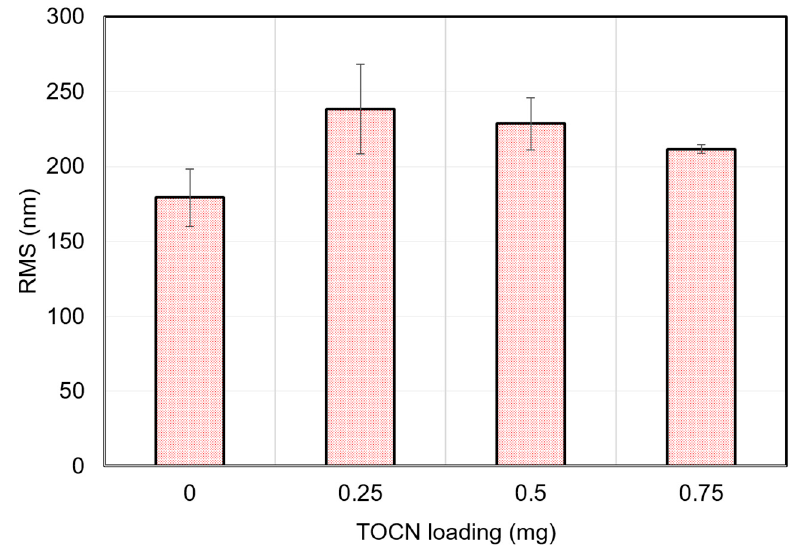
Figure A4. RMS roughness data from AFM scans of membranes fabricated with TOCNs via the vacuum filtration method.